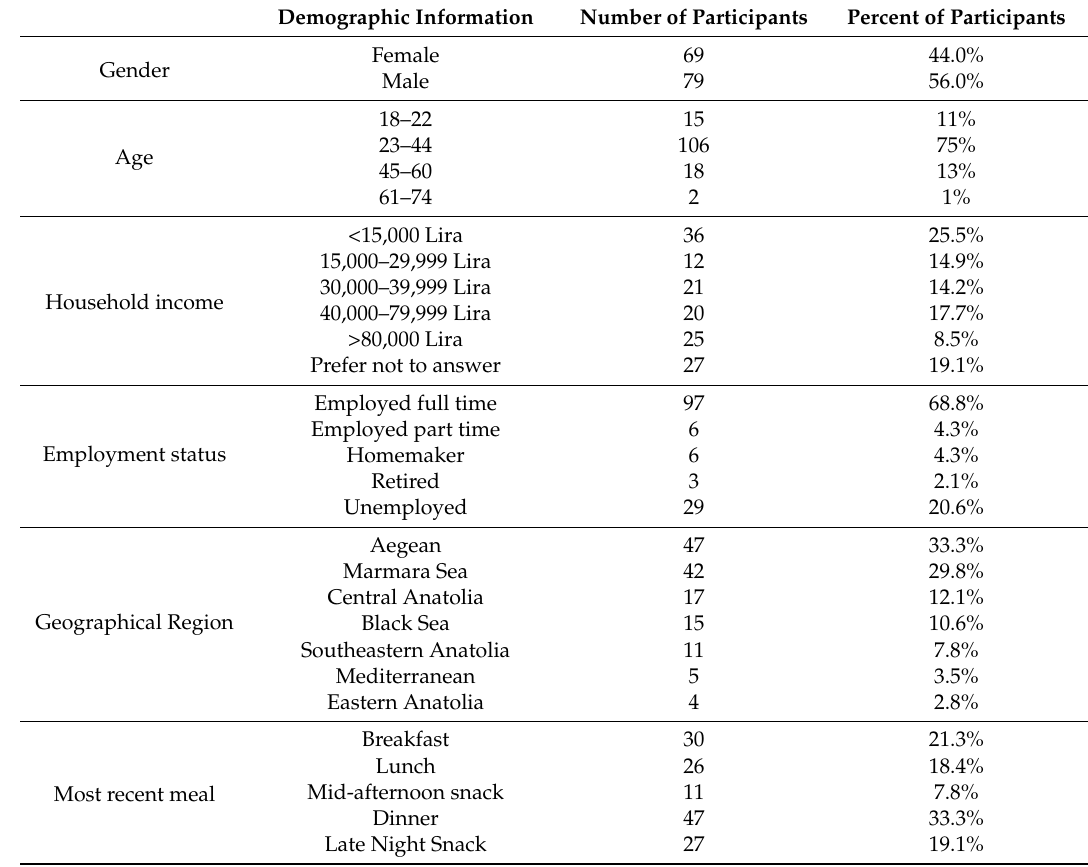
Table 1. Demographic information representing the participants in the study ( N =